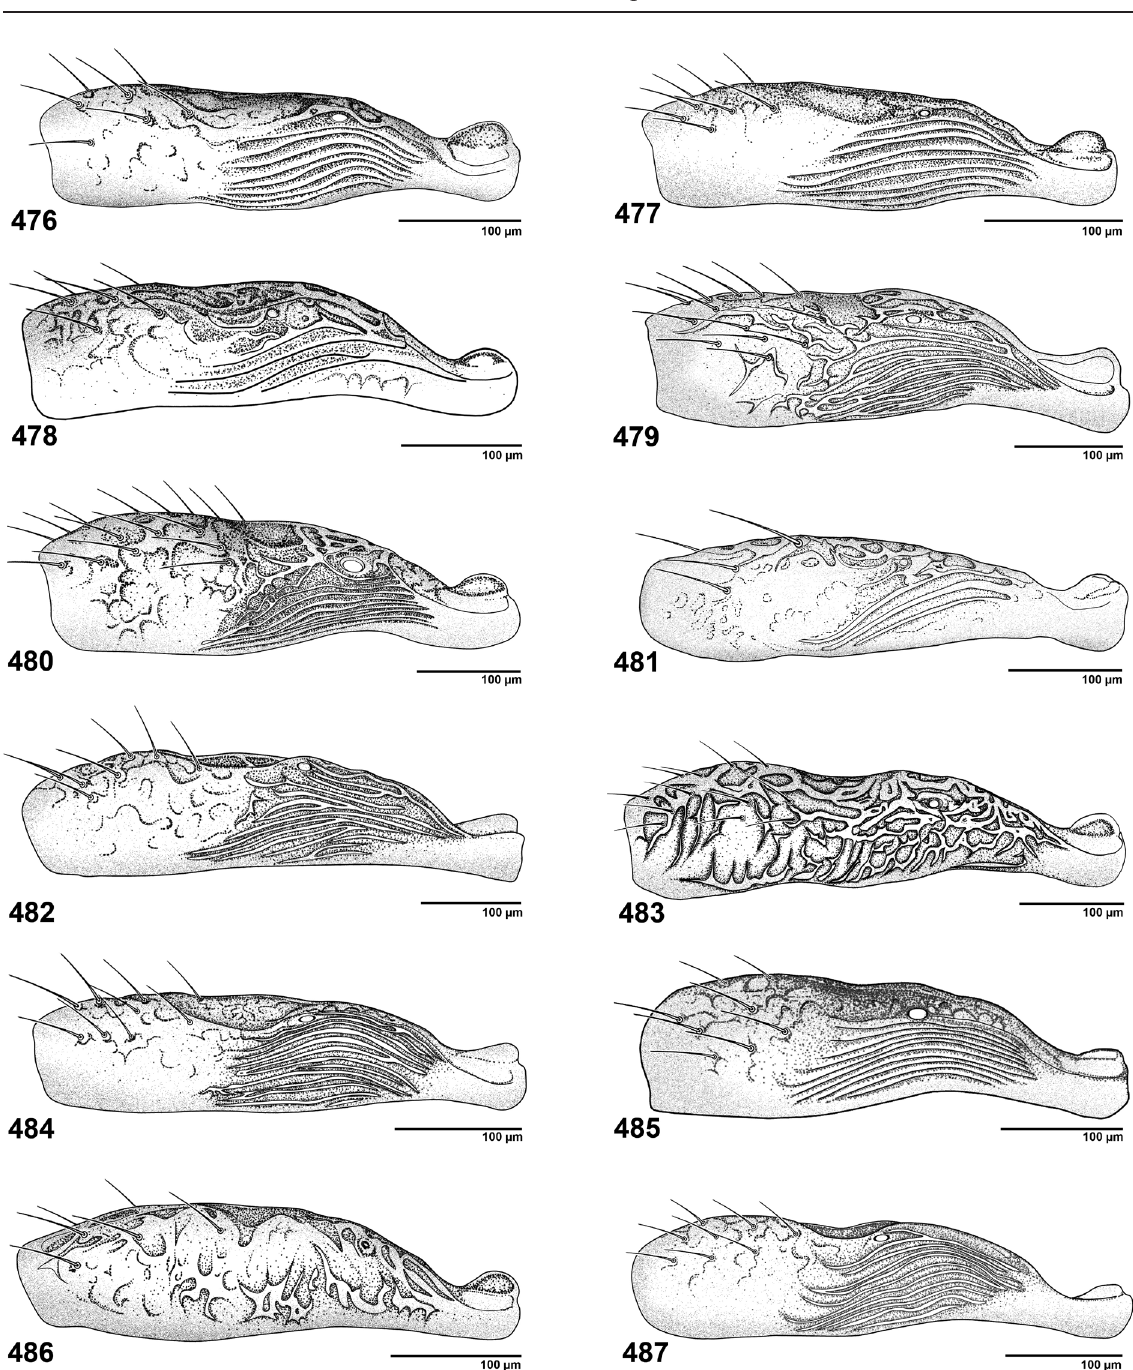
Figs 476–487. Anterolateral aspect of petiole in Aphidius species (♀): 476 . Aphidius absinthii . 477 . Aphidius asteris . 478 . Aphidius avenae . 479 . Aphidius banksae . 480 . Aphidius cingulatus . 481 . Aphidius colemani . 482 . Aphidius eadyi . 483 . Aphidius ervi . 484 . Aphidius funebris . 485 . Aphidius matricariae . 486 . Aphidius microlophii . 487 . Aphidius persicus